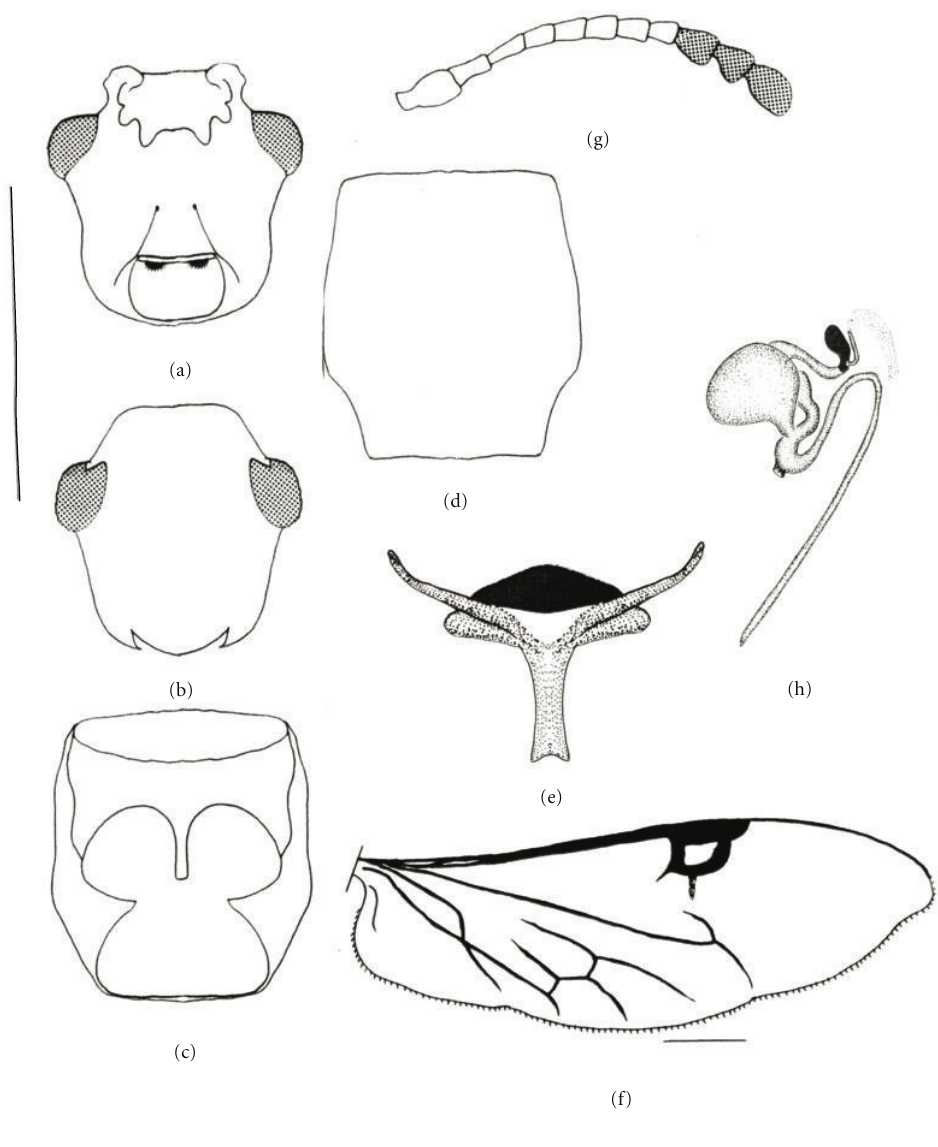
Figure 7: Various organs of Blackburniella intricata . (a, b) Head ((a) ventral, (b) dorsal). (c, d) Pronotum ((c) ventral, (d) dorsal). (e) Metendosternite. (f) Metathoracic wing. (g) Antenna. (h) Female mesodermal organs. length of pedicel and antennomere 3, funicular anten- nomeres subfiliform, capitular antennomeres wide, anten- nomeres 9 and 10 expanded laterally, antennomere 11 trans- verse. Thorax : pronotum (Figures 11(c) and 11(d)), trans- verse, disc indented with large setiferous punctations, with central linear fissure, and small paralateral elevations, side margins with distinct tubercle, dorsolateral ridge extends from posterior angle to anterior angle, not fractured but made coarse by coarse punctations, sclerotized region above pronotal projection setose, not glabrous, prebasal fissure well developed, prointercoxal process expanded distally;